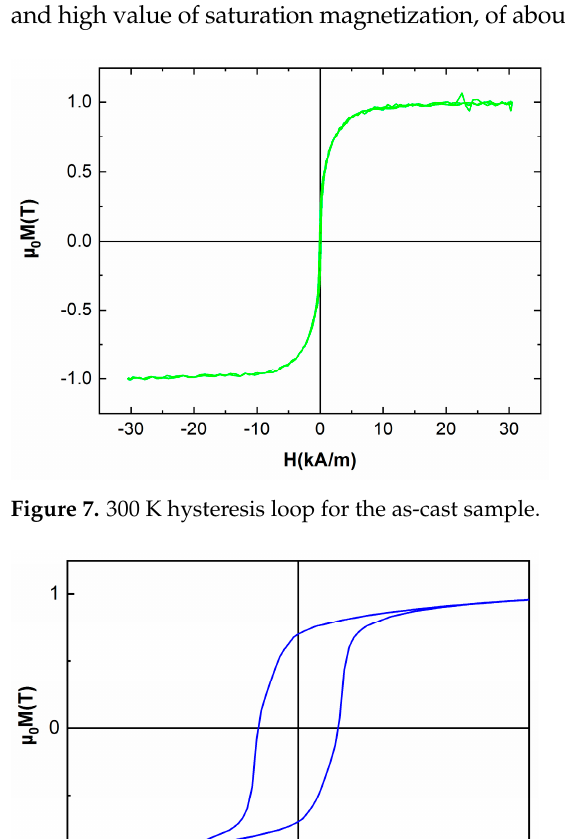
Figure 9. Demagnetization curve plotted from the hysteresis loop for the annealed sample.